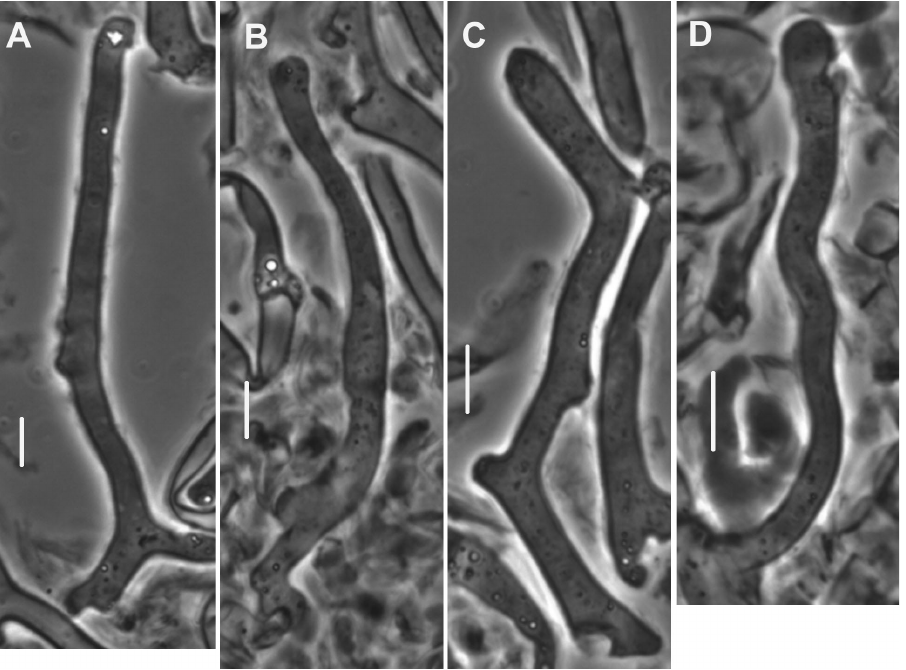
Figure 51. Mycetinis opacus . Pileal hairs. Standard bars = 10 µm. TFB 14629 (TENN-F-69344). 5A2, “pale yellow-orange” 4A3, pale greyish buff or white; in age pileus typically with a pale greyish brown disc region and white margin, in wet weather entire pileus some- times becoming white. Context thin (<1 mm), buff. Lamellae adnate or